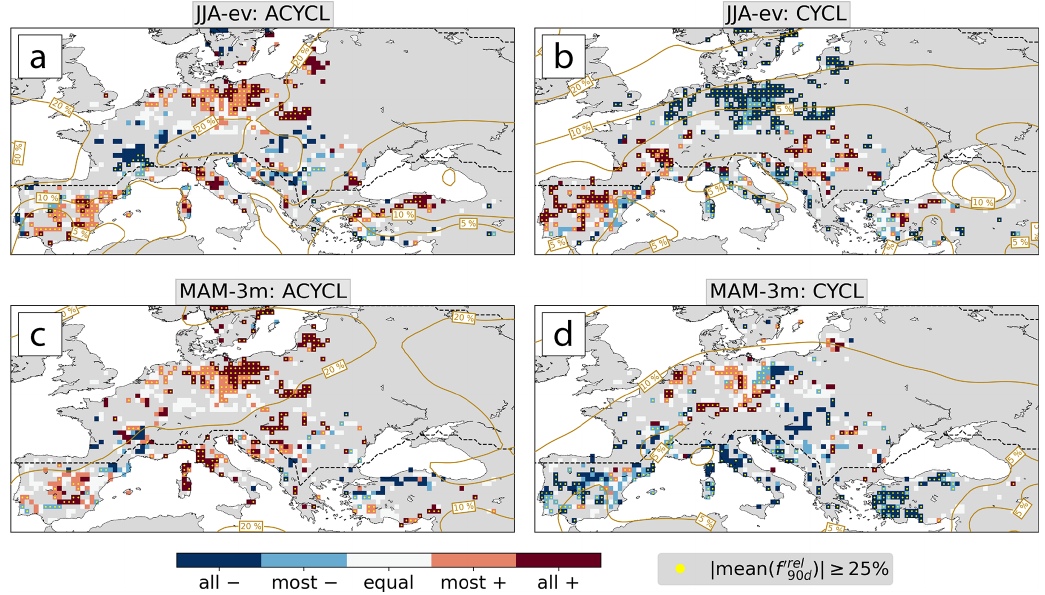
Figure 7. The consistency in the sign of (a, c) f (cid:48) rel 90d (A) and (b, d) f (cid:48) rel 90d (C) for all forest grid cells with at least two low-NDVI events in 2002–2022. Maps are shown for the last day of (a, b) JJA-ev and (c, d) MAM-3m. Stippling indicates that the absolute average over all anomalies of the same sign is at least 25%. Two-dimensional Gaussian-smoothed (2 σ ) climatological weather system frequencies are shown in beige